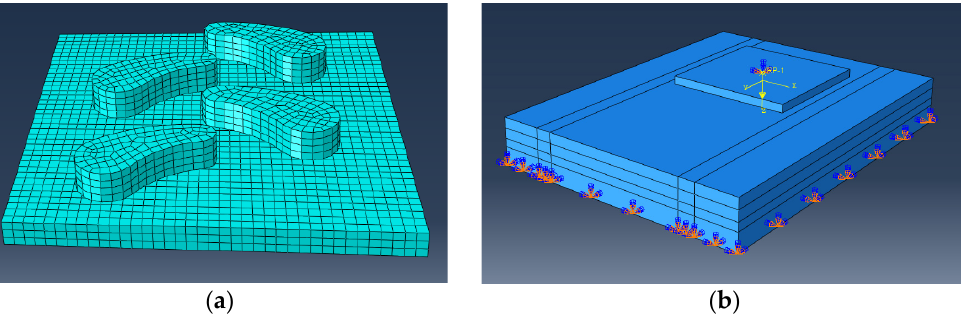
Figure 5. Simulation model: ( a ) the bionic-tire-block model after grid division; ( b ) the simulation model with constraints set. (note: in the figure, RP-1 is the reference point of vector force, which is equivalent to applying a certain load at the center of mass of the bionic tire-block. The orange and blue symbol at the bottom is a constraint on the soil bed which prohibits it from moving).